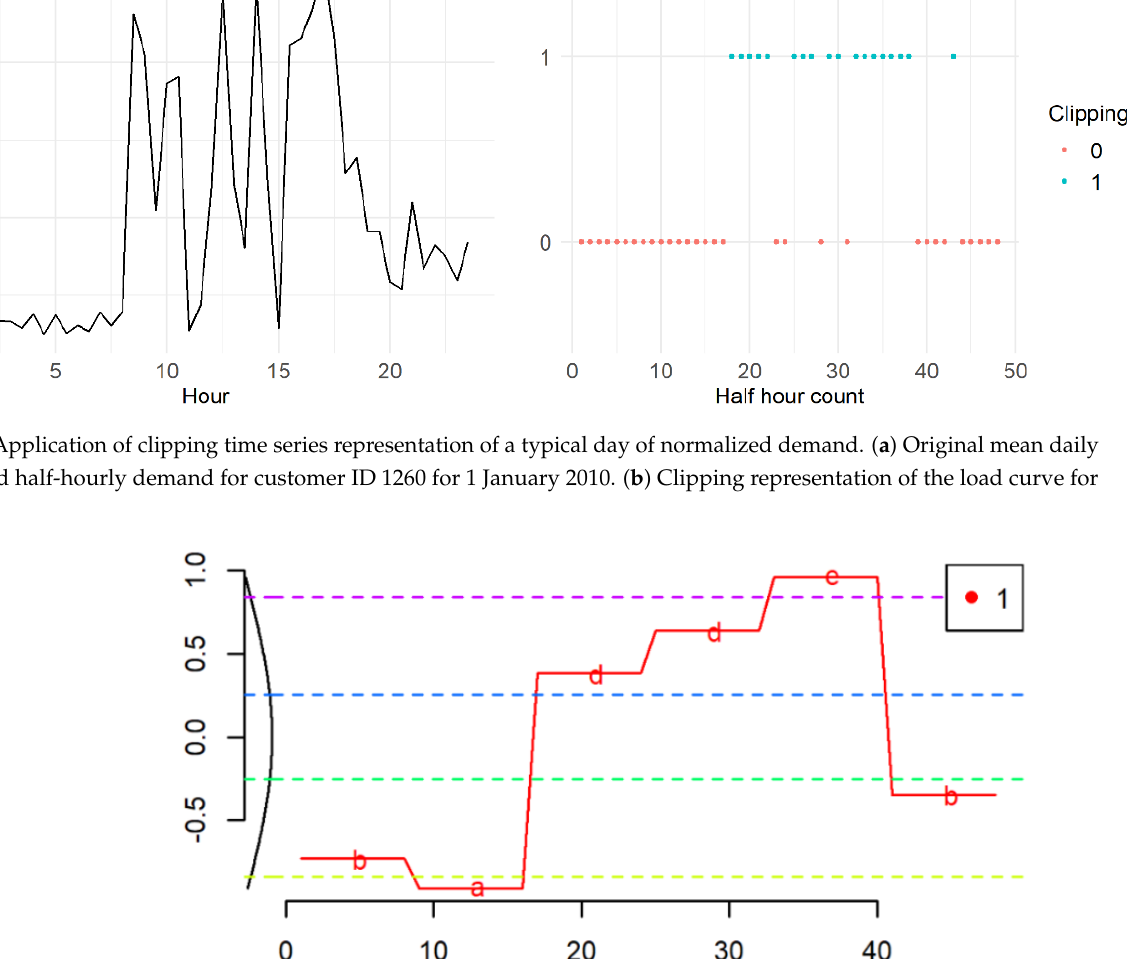
Figure 8. Application of PAA and SAX time series representation to the scaled mean daily normal- ized half-hourly demand for customer ID 1260 for 1 January 2010.